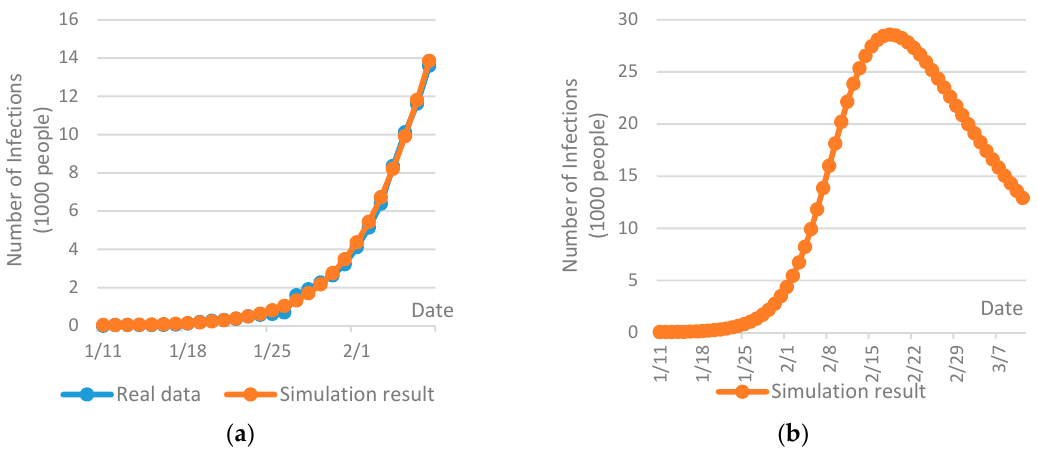
Figure 2. Prediction of the tendency of the COVID-19 spread in Wuhan with SEIR method in AnyLogic simulation: ( a ) Curve fit with the real data; ( b ) Predication of the infections in two months.